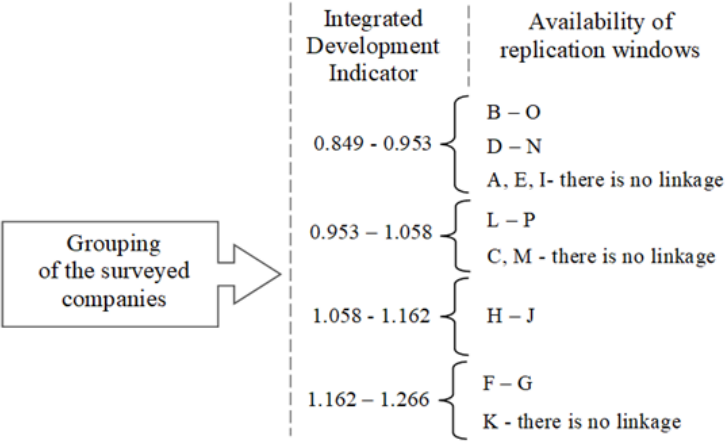
Figure 2. Grouping of the surveyed companies according to paired replication of integrated development. Source: Formed by the authors.